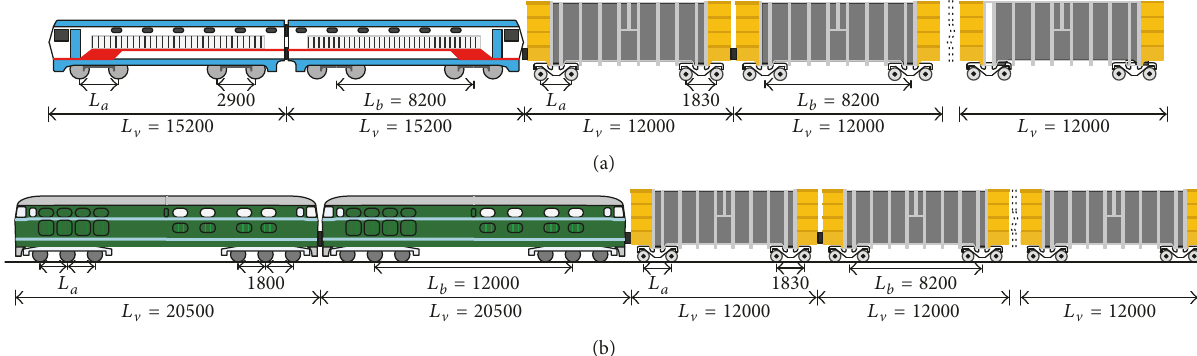
Figure 5: The layout and geometrical specification of trains. (a) SS 4 B + C 80 B and (b) DF 4 B + C 80 B